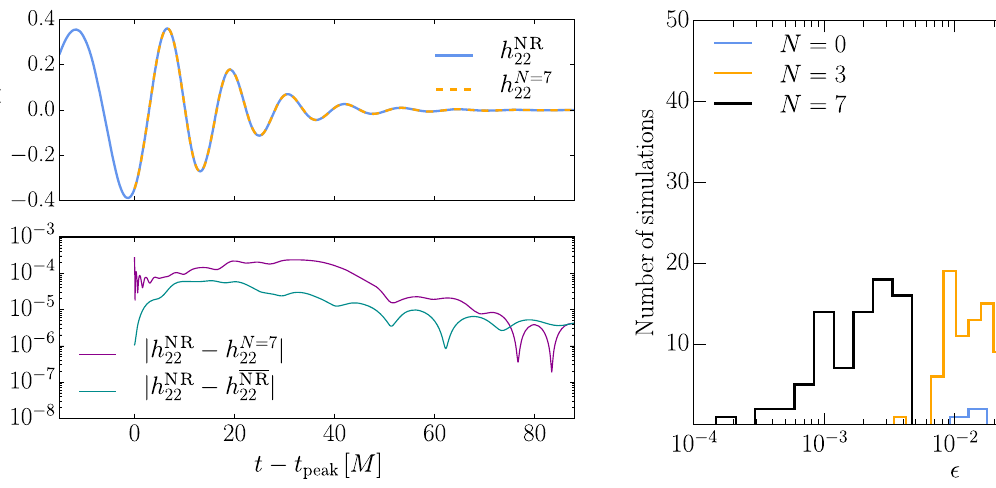
FIG. 3. The distribution of ϵ , Eq. (4), for a range of simulations .FIG. 2. Comparison between the plus polarization of the l ¼ m ¼ 2 mode of the NR waveform and the N ¼ 7 linear QNM in the SXS catalog. The distribution includes systems with mass ratios up to 8 and orbit-aligned component spins with j ⃗ χ j ≤ 0 . 8 . model. The QNM model begins at t 0 ¼ t . The upper panel peak The distributions shown are for N ¼ f 0 ; 3 ; 7 g overtones at the shows both waveforms, and the lower panel shows the residual peak of the strain amplitude. For the best performing model, for t ≥ t . For reference, the lower panel also shows an estimate peak N ¼ 7 , the median value is 2 × 10 − 3 , and the maximum error in of the error in the NR waveform, j h NR 22 − h NR 22 j , where h NR 22 refers estimating the mass and spin is about 5 × 10 − 3 to the highest resolution waveform of SXS:BBH:0305 and h NR 22 refers to the next highest resolution waveform for this same system. The two NR waveforms are aligned at t 0 ¼ t , in both peak time and